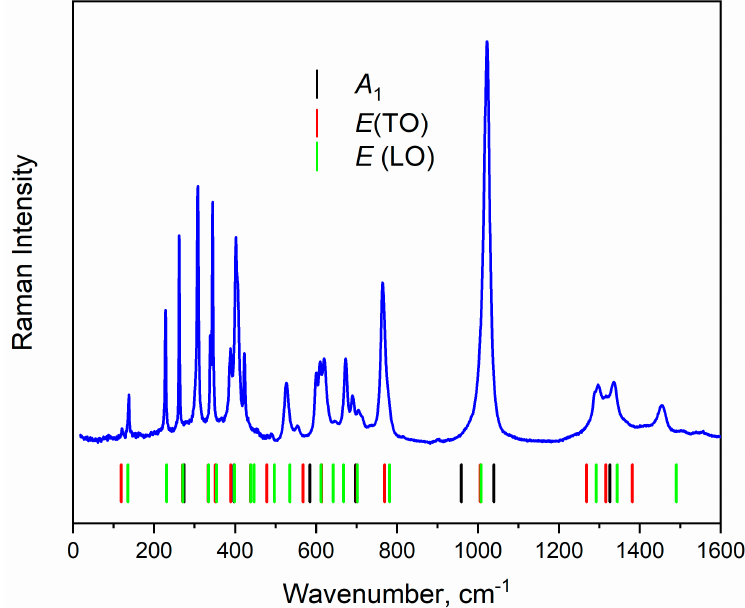
Figure 6. Raman spectra of YAl 3 (BO 3 ) 4 recorded at 532.1 nm. Vertical lines show the positions of calculated Raman-active bands.